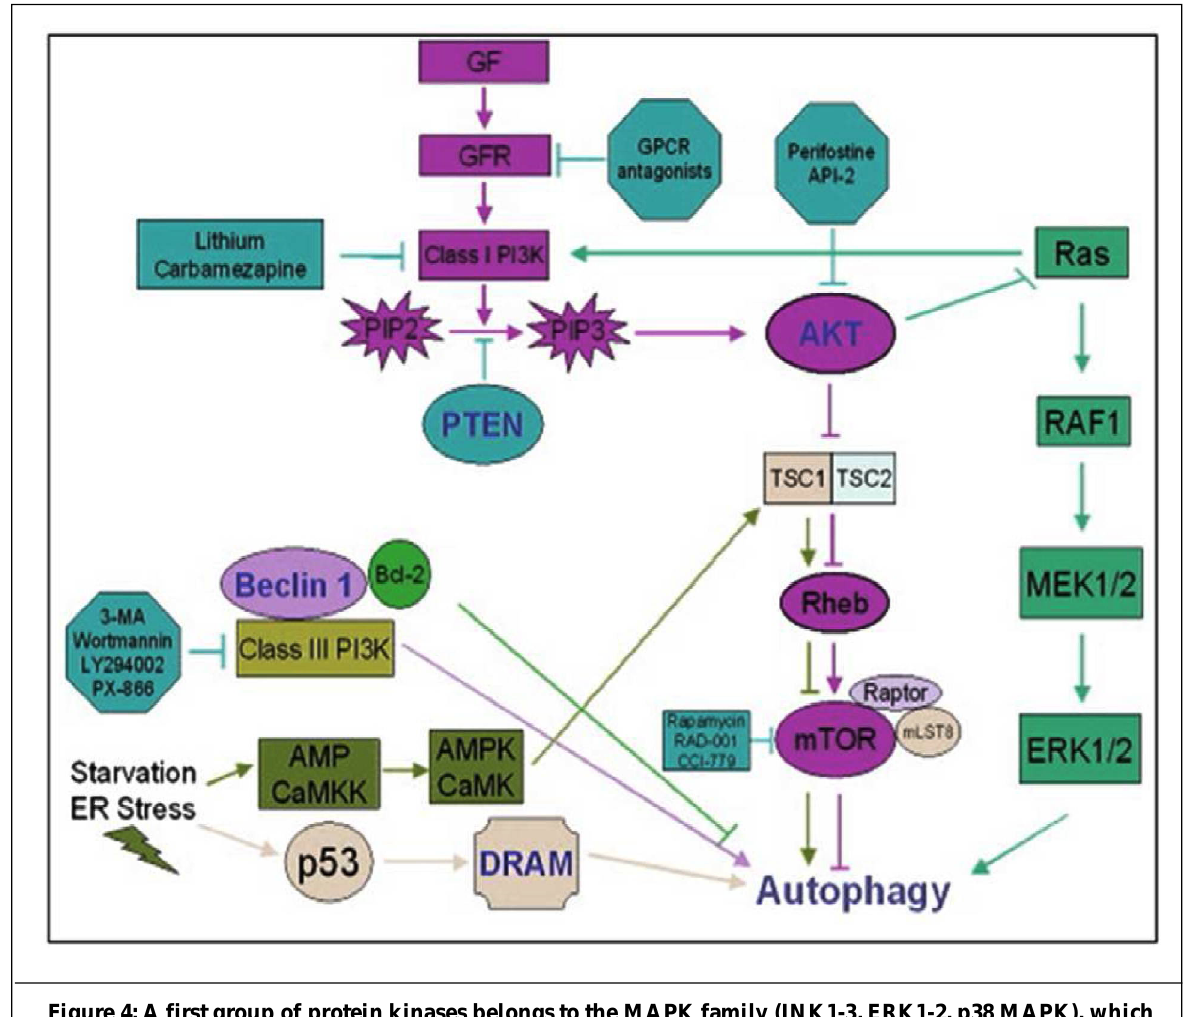
Figure 4: A first group of protein kinases belongs to the MAPK family (JNK1-3, ERK1-2, p38 MAPK), which is known to respond to several types of stress, such as membrane damage, oxidative stress, osmotic shock, heat shock, (Chen V, Karantza-Wadsworth V. Role and regulation of autophagy in cancer. Biochim. Biophys. Acta. 2009; 1793(9):